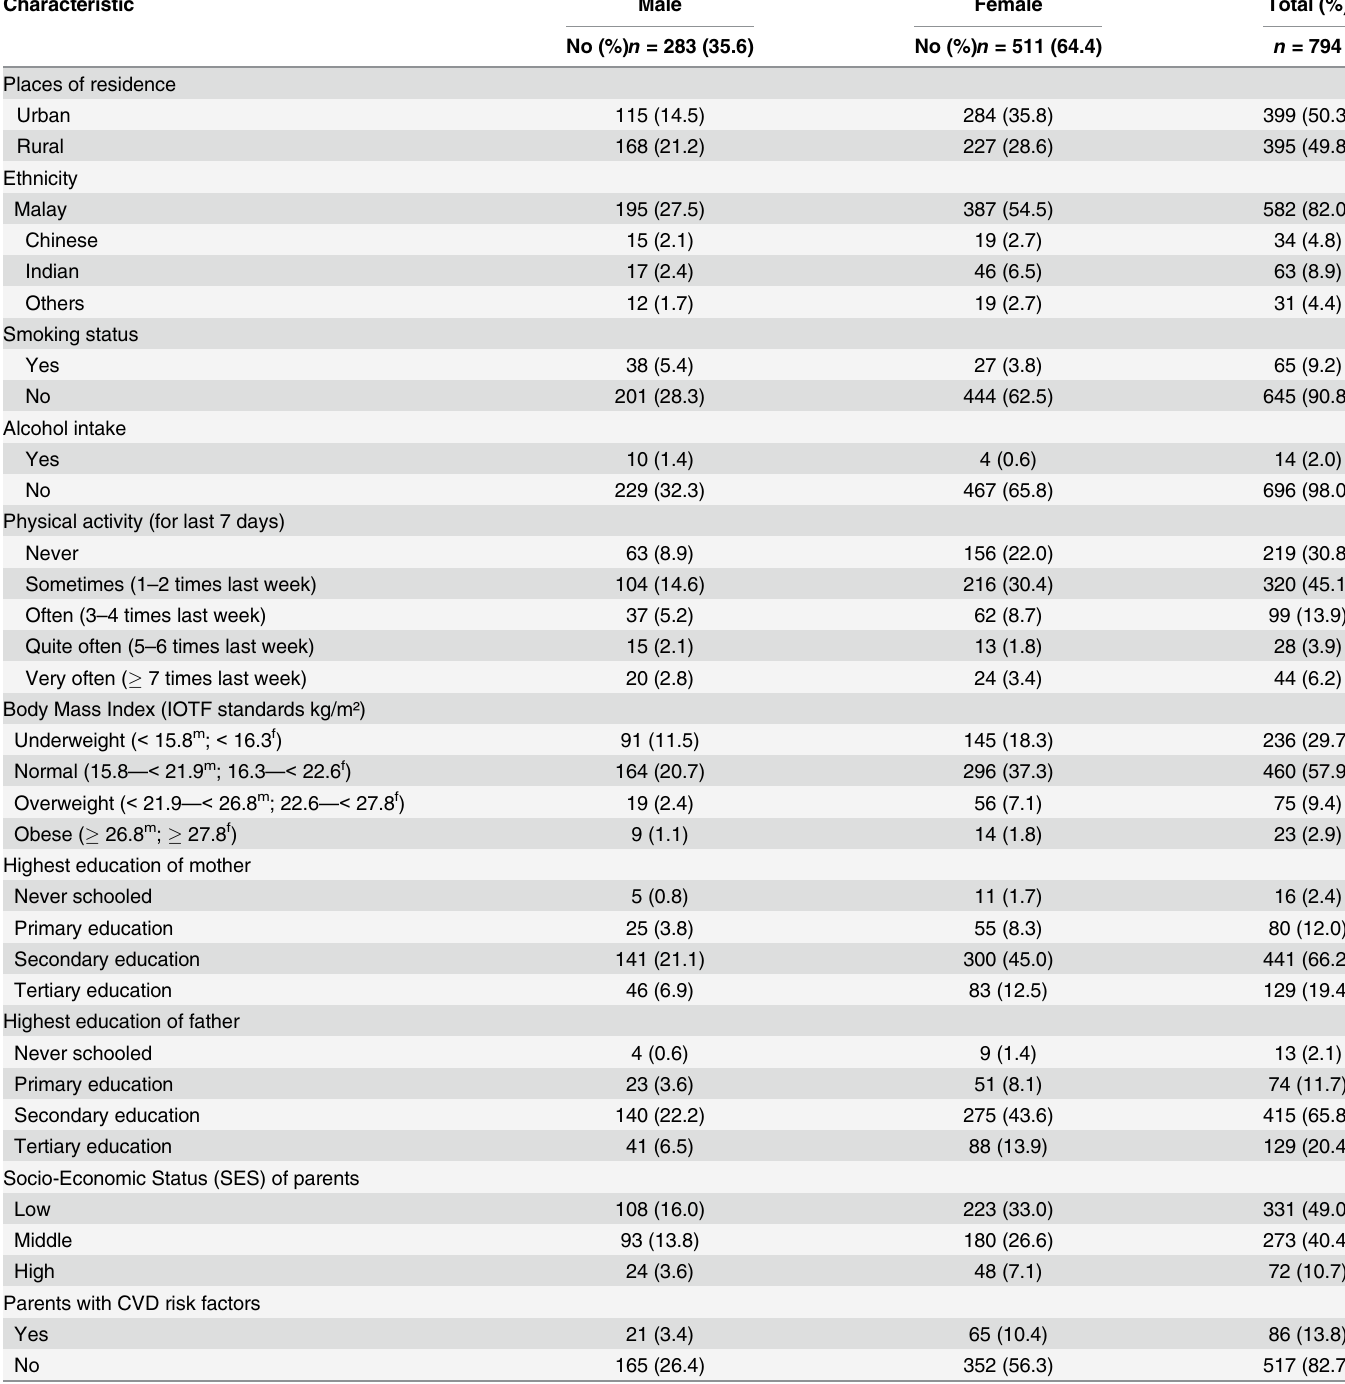
Table 1. Characteristic of adolescents age 13 y attending secondary school by